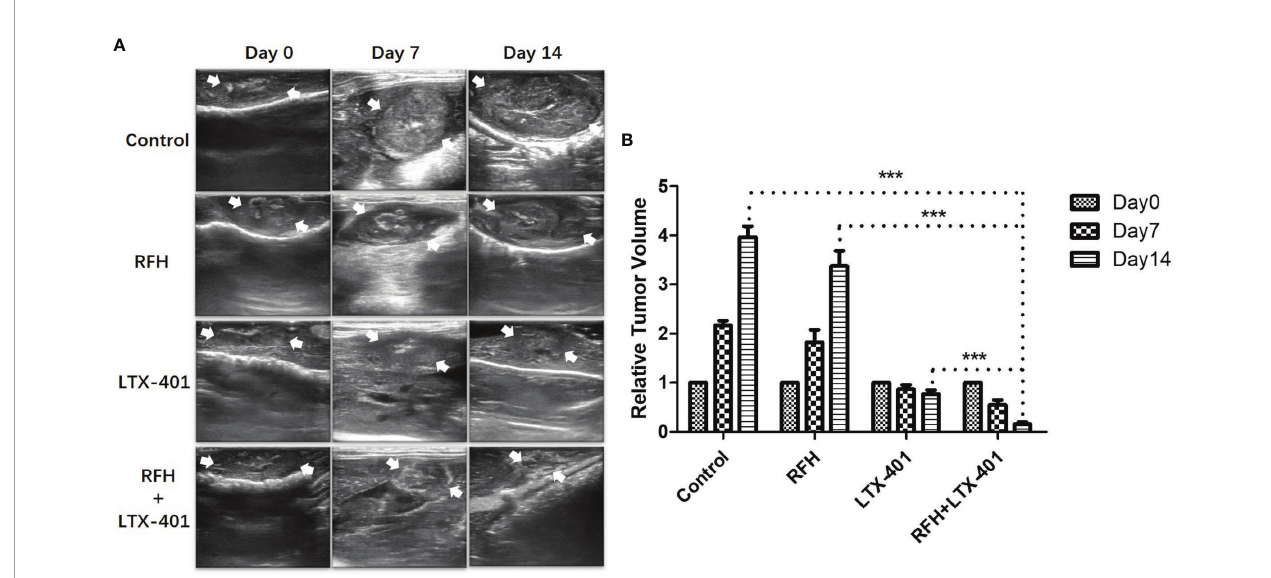
FIGURE 7 | Ultrasound-imaging follow-up of different treatment groups. (A, B) Ultrasound images demonstrate signi fi cantly decreased sizes of the treated tumors (between arrows) at day 14 after the combination therapies with LTX-401 plus RFH, compared to other monotherapies (***= P